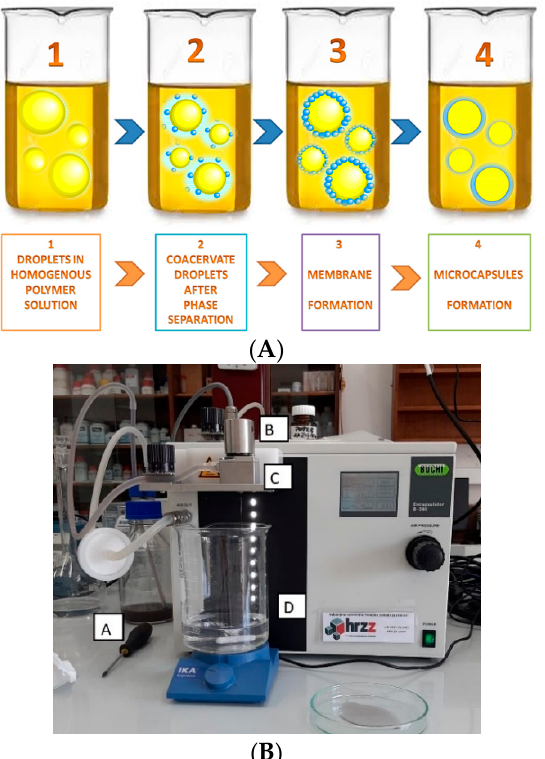
Figure 1. ( A ) Steps in encapsulation by coacervation prior the functionalization, ( B ) encapsulation apparature Buchi Encapsulator B-390 manufacturer Buchi Labortechnik AG (Flawil, Switzerland) (A—500 mL bottle with encapsulating agent; B—magnetic vibrator; C—heater; nozzle at the